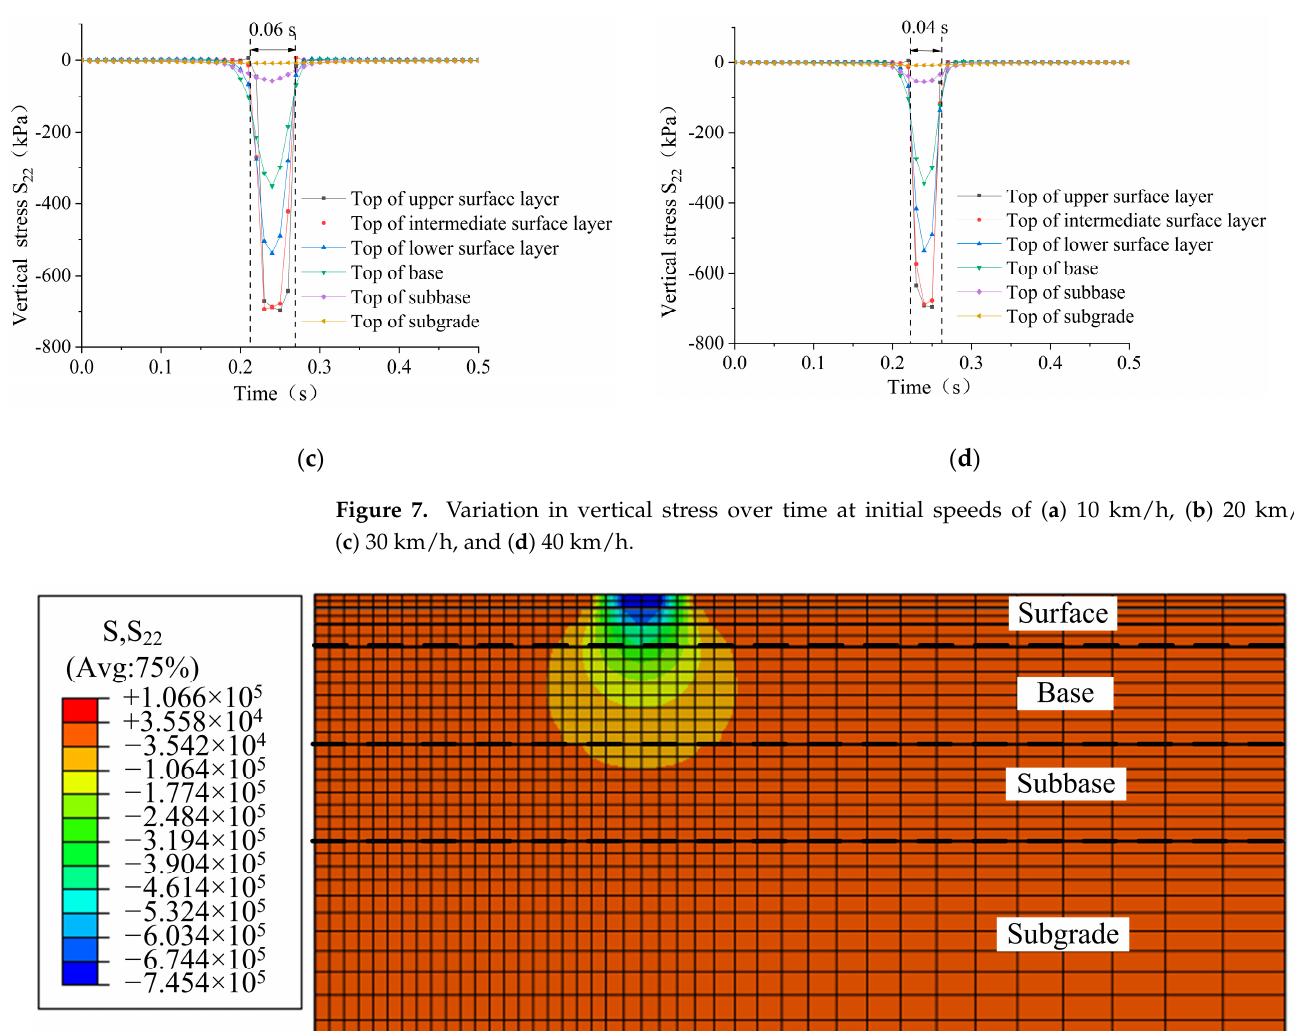
Figure 8. Vertical stress in middle section when load moves over it at initial speed of 10 km/h.